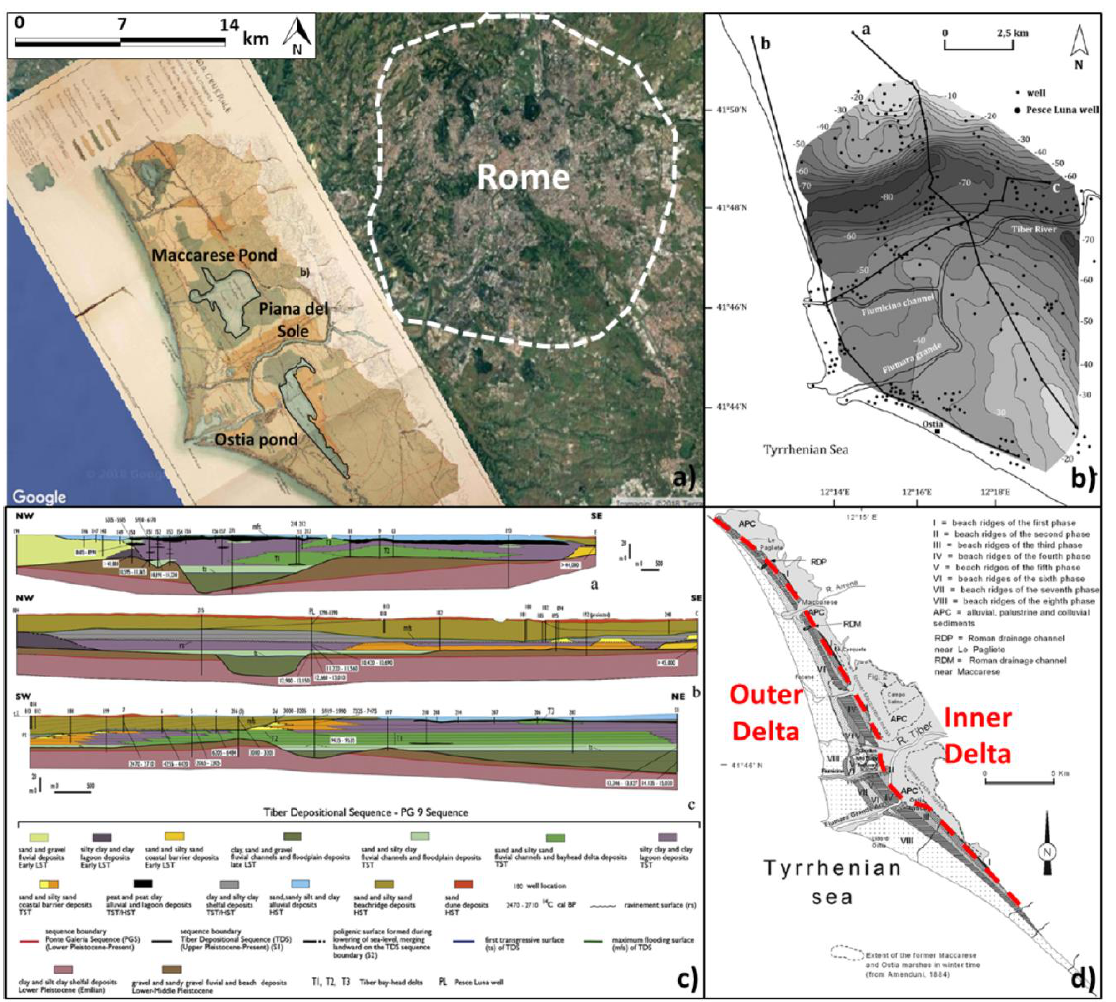
Figure 1 . ( a ) Location of the study region over the map by Amenduni [25], in which the ancient Maccarese and Ostia ponds are highlighted (white dashed line identifies the Grande Raccordo Anulare, i.e., the ring-shaped motorways around Rome City Center; ( b ) Contour map of the unconformity at the base of the Tiber depositional sequence; ( c ) Stratigraphic cross-sections of the Tiber depositional sequence (see Figure 1b for the location of the traces) from Milli et al. [39]; ( d ) Morphological features of the Tiber delta (redrawn from Giraudi [36]). LST, lowstand system tract; TST, transgressive system tract; HST, highstand system tract.